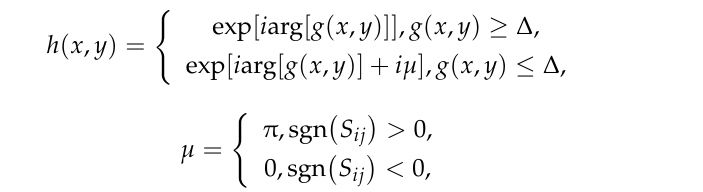
Table 5. The action of the 25-channel DOE illuminated with vortex beams with a TC l = 1, 3, 5.